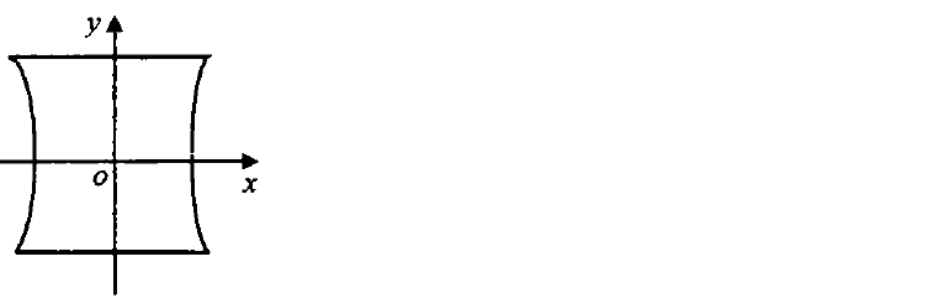
Figure 5. Schematic of nonlinear relationship between galvanometer driving and projection coordi-